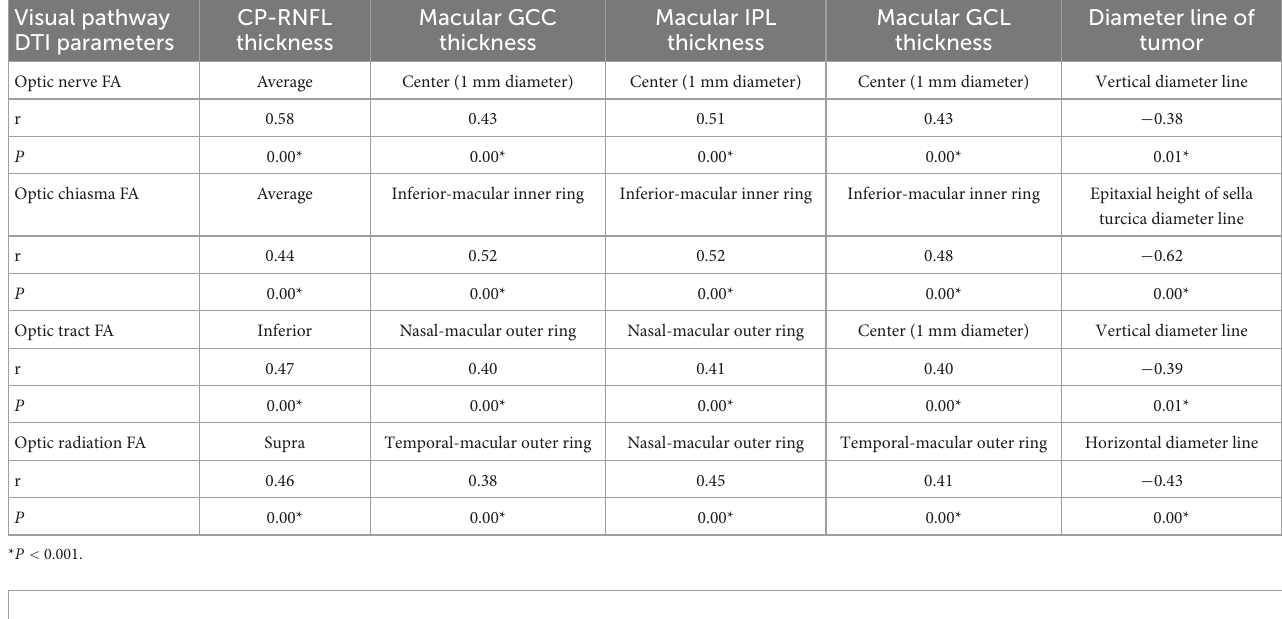
TABLE 6 The strongest correlation between DTI parameters and OCT parameters.